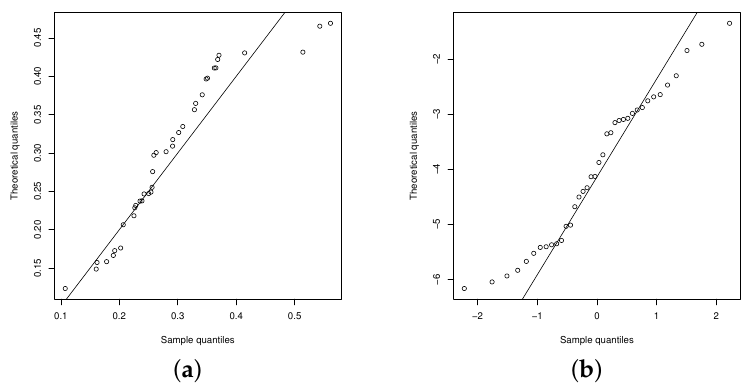
Figure 6. QQplot: ( a ) beta regression model and ( b ) UN regression model.